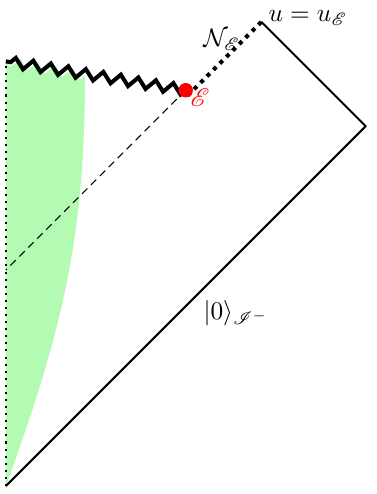
Figure 8. The region under semiclassical control in an evaporating black hole spacetime. In the far past, the diagram coincides with 2(a) and the black hole forms from collapse of matter. This region is bounded by the jagged line (called the ‘singularity’), its endpoint E , and the outgoing null congruence N E (dotted line). Planck scale physics becomes important at the singularity and E , and may influence further evolution of the spacetime. The event horizon H + (dashed line) is defined to be the boundary of the past domain of dependence of the singularity and E , and we refer to this past domain of dependence as the black hole interior.